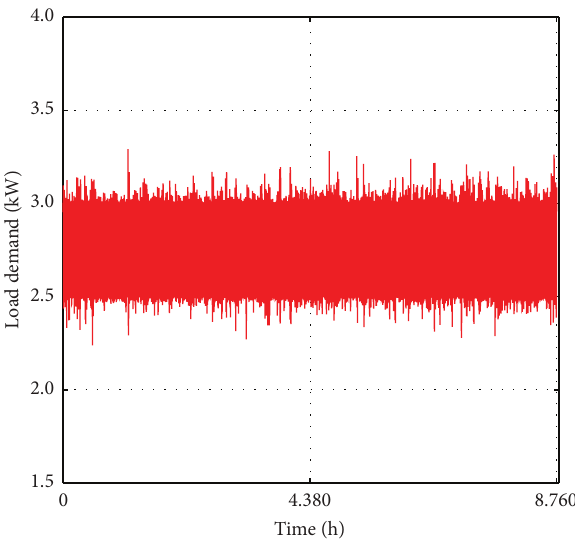
Figure 6: Adjusted hourly load profile for GSM outdoor base